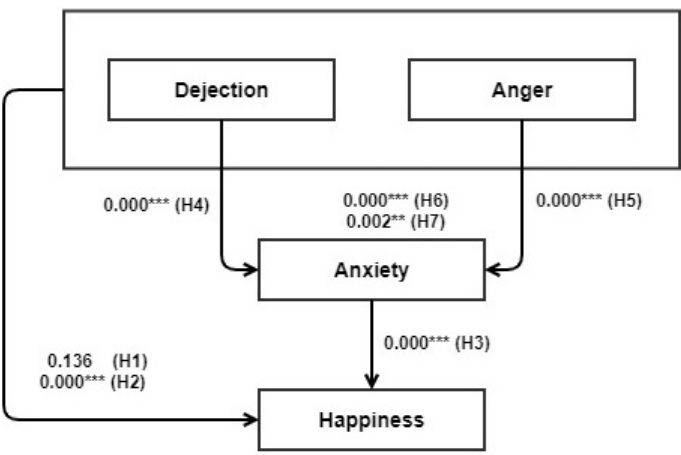
Figure 4. Final WORAF model ( p -values). ** p < 0.01. *** p <